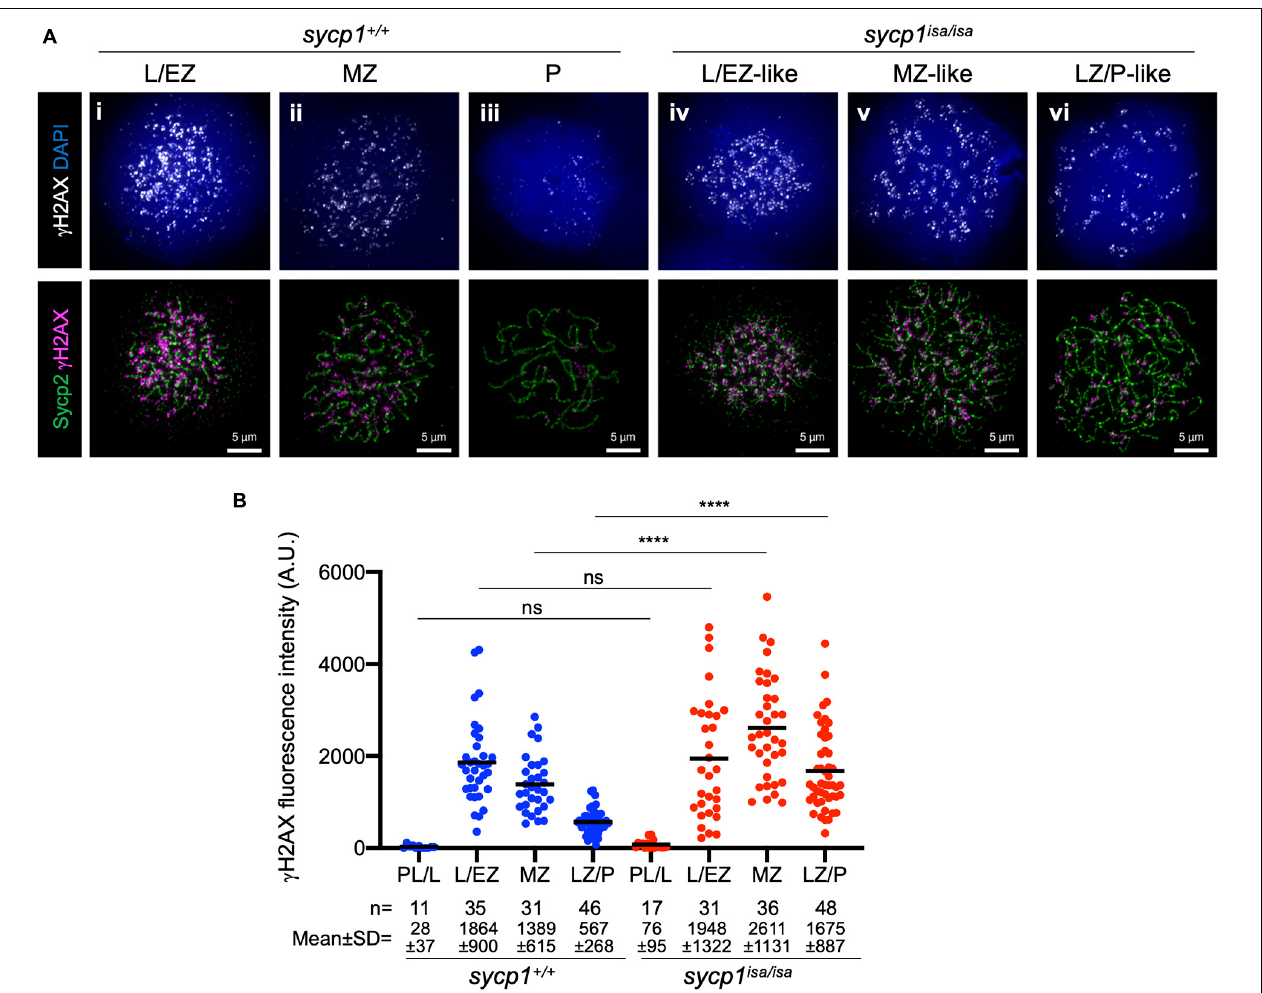
FIGURE 5 | Meiotic DSB formation in sycp1 mutant spermatocytes. (A) costaining of γ H2AX and Sycp2 in sycp1 + / + (i to iii) and sycp1 isa / isa (iv to vi) spermatocytes. (B) quantification of γ H2AX signal intensity in sycp1 + / + and sycp1 isa / isa spermatocytes. Black bars indicate means. Statistical significance was examined by a two-tailed Mann-Whitney test (**** P < 0.0001, ns, not significant; exact P